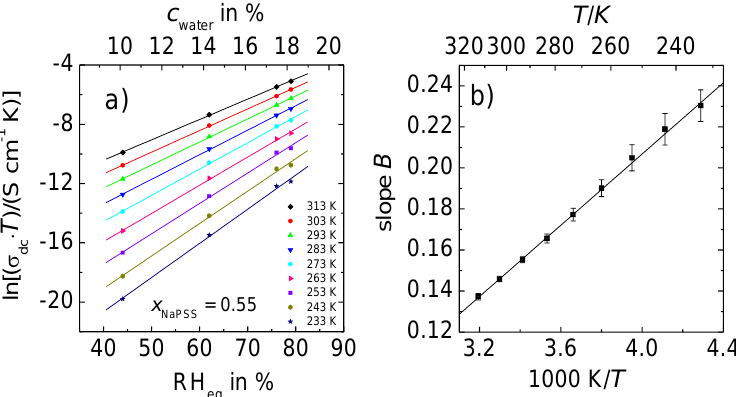
Figure 4. Data of PEC with x NaPSS = 0.55 at constant water content. ( a ) ln(σ dc T ) versus RH eq ; ( b ) Parameter B (slope determined from Figure 4a) as a function of the inverse temperature.